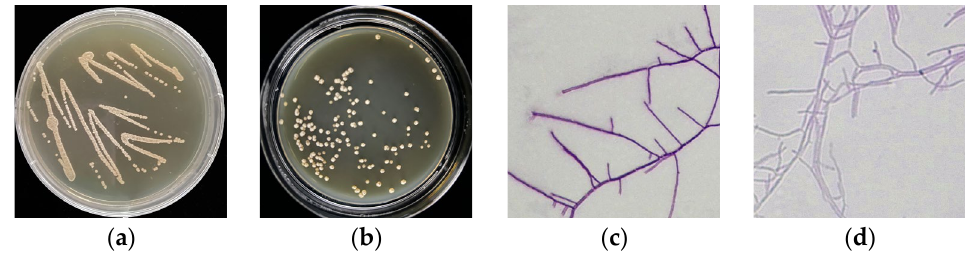
Figure 2. Colonies of strains 891 ( a ) and 891-B6 ( b ) and their mycelia ( c , d ).